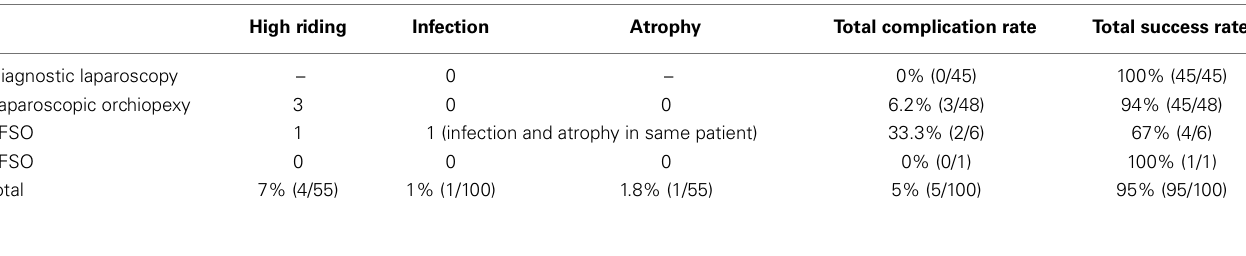
Table 2 | Distribution of complication